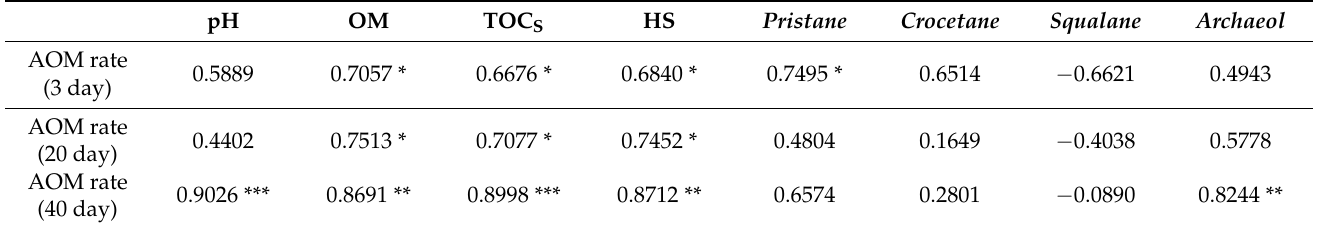
Table 5. Pearson correlations ( r ) between AOM rate and sediment